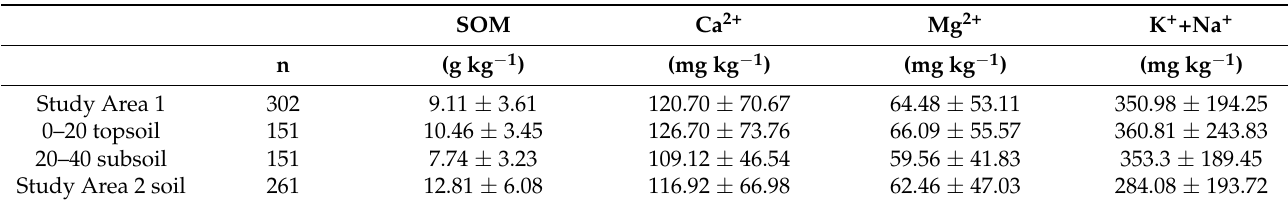
Table 1. Statistics of soil properties.